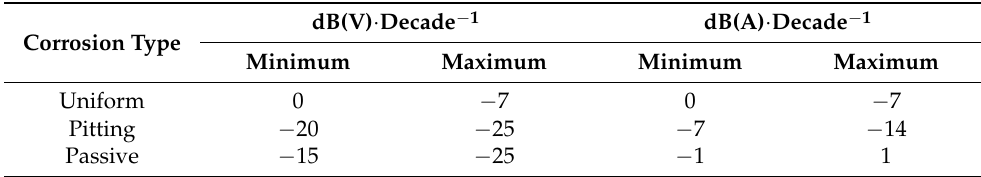
Table 6. β intervals to indicate the type of corrosion [70].